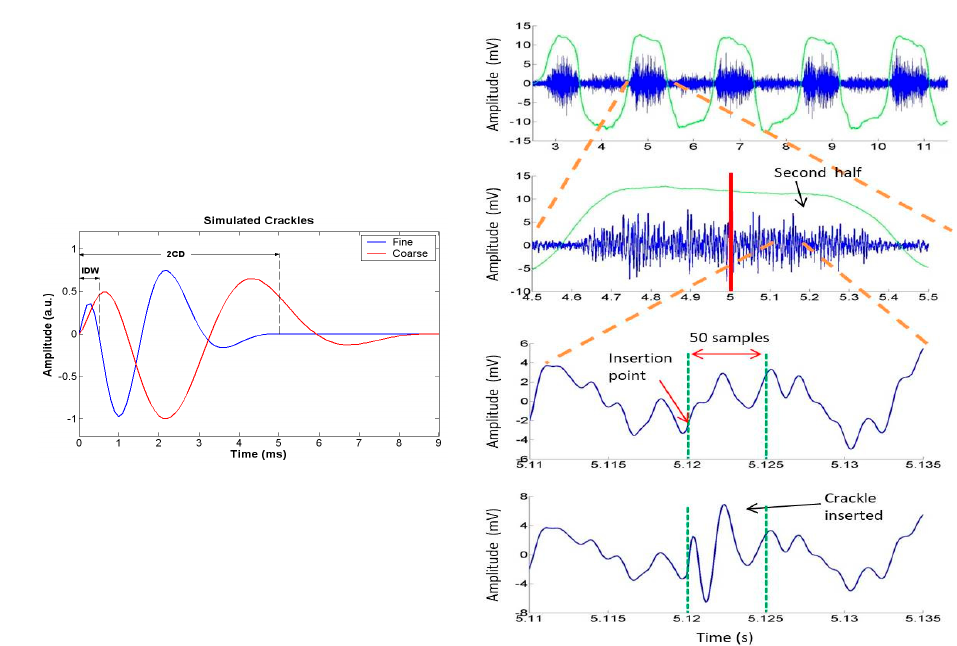
Figure 6. Simulated scenarios with synthetic crackle sounds. Left : Waveform of simulated fine and coarse crackles. Right : Insertion of a synthetic fine crackle at a random location using a gain factor equal to 3.5 times the variance of the basal sound in the insertion window.